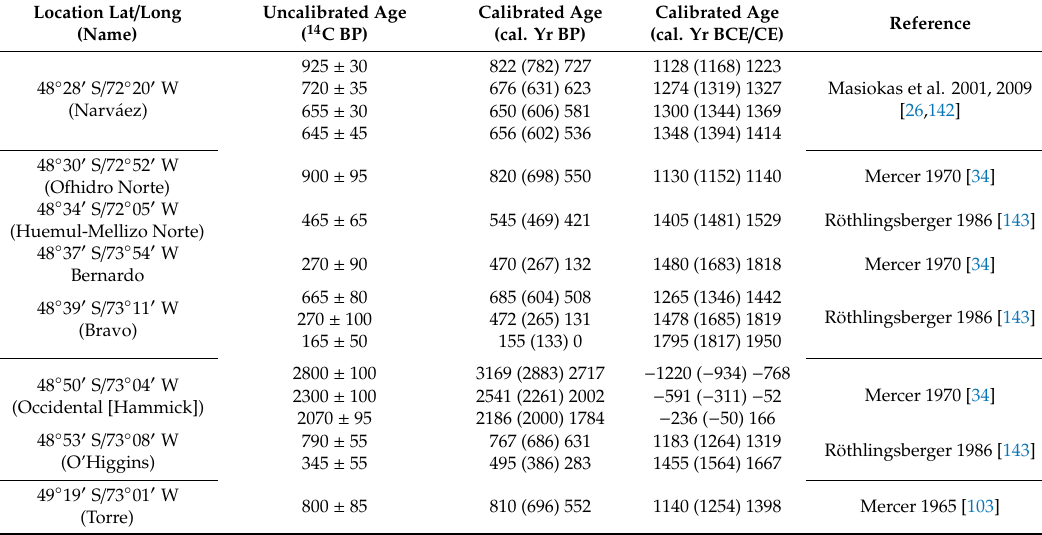
Table A2. Glacier Advances Derived from 14 C Dates and Paleoclimatic Studies Used in this Study: Dates are Reported as Calibrated 2 σ -Age Ranges, Including the Median Probability of Distribution Function Given in Brackets. Calibration was Performed Using the CALIB 7.1 Software [83] and the SHCal13 Calibration Curve [84]. If Original / Uncalibrated 14 C Data were not Available, the Calibrated Data were Acquired Directly from the Respective